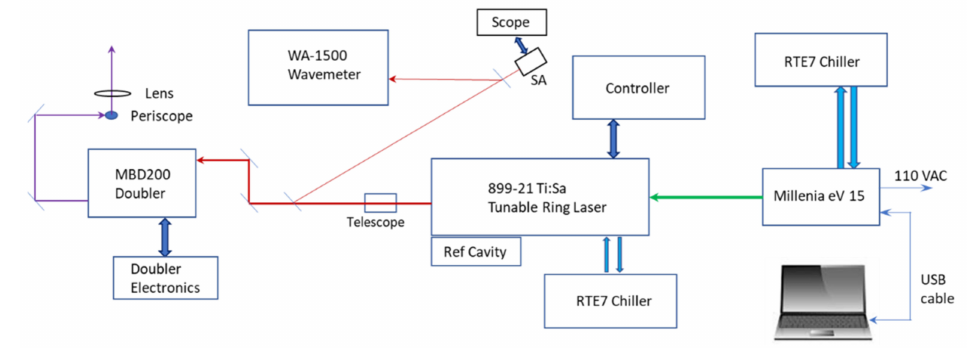
Figure 1. Diagram of tunable laser system used for the LIF